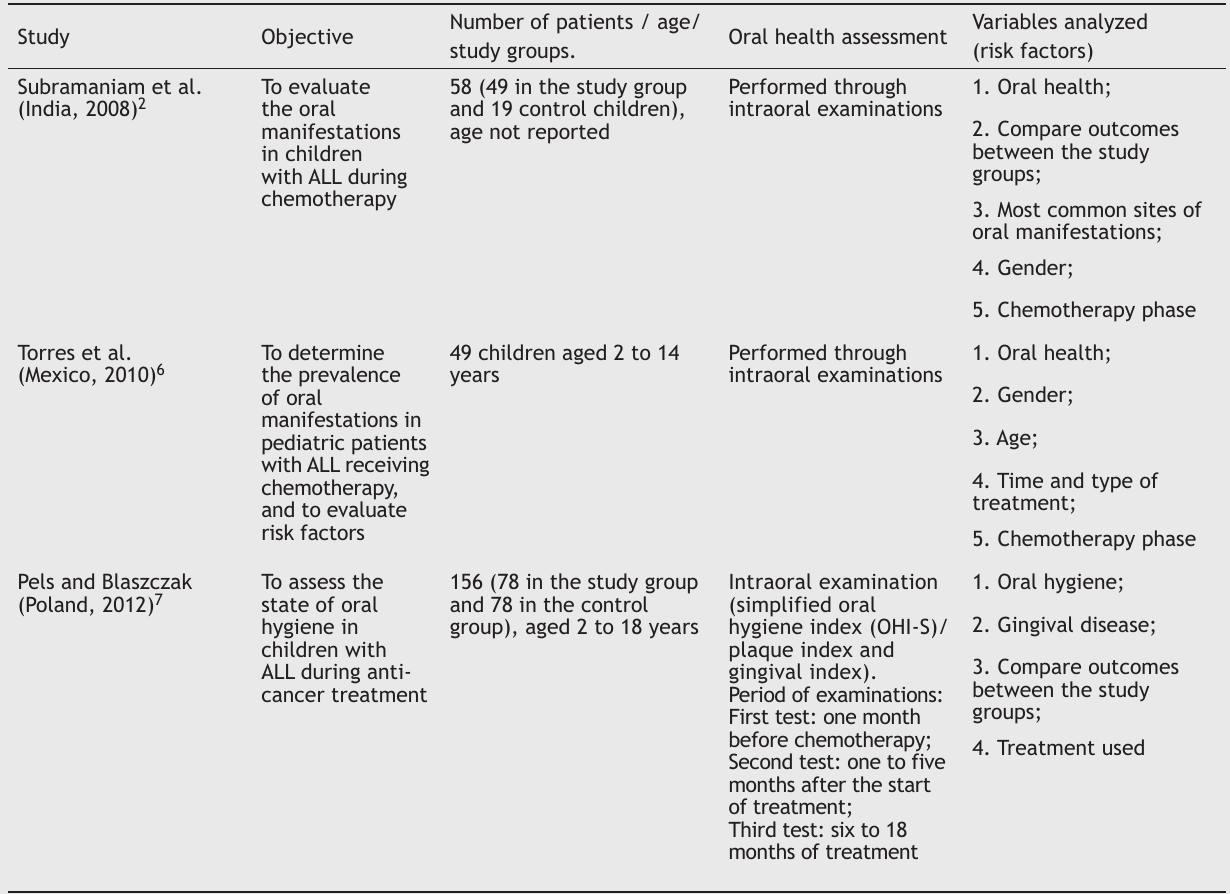
Table 2 Methodology and objectives of the selected